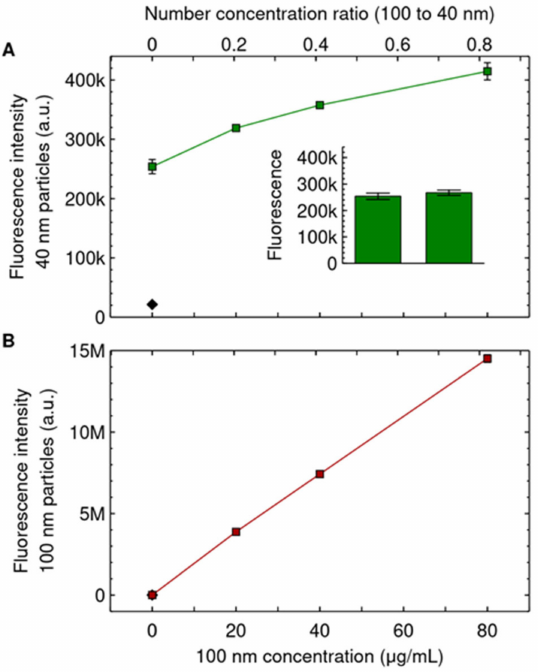
Figure 4. Competing 100 nm particles promote uptake of the 40 nm particles. Cells were exposed for 24 h to both 40 and 100 nm particles simultaneously. The 40 nm particle concentration was kept constant at 6.25 µ g/mL (0.30 nM), while the concentration of the 100 nm particles was varied (horizontal axes). ( A ) Uptake of the 40 nm particles, showing that as the concentration of the competing 100 nm particles is increased, the uptake of the 40 nm particles increases. (Inset) Cells exposed to the two dispersions of only the 40 nm particles (6.25 µ g/mL; 0.30 nM) as a control for having achieved a similar concentration of the 40 nm particles ( cf. Figure 1A–B, but with the role of the 40 and 100 nm particles reversed). Same y axis as the main figure. ( B ) Uptake of the 100 nm particles, showing that the uptake of the competing 100 nm particles increases as their concentration is increased. Results are presented as the mean ± its standard error over 3 samples (most error bars are, however, smaller than the data symbols and are hence not visible). Diamonds corresponds to control cells (not exposed to either of the particles). Repeat experiments are shown in Figure S4. A Mack– Skillings test with independent experiments as blocking factor and replicate samples as multiple observations shows a statistically significant difference with competing 100 nm particle